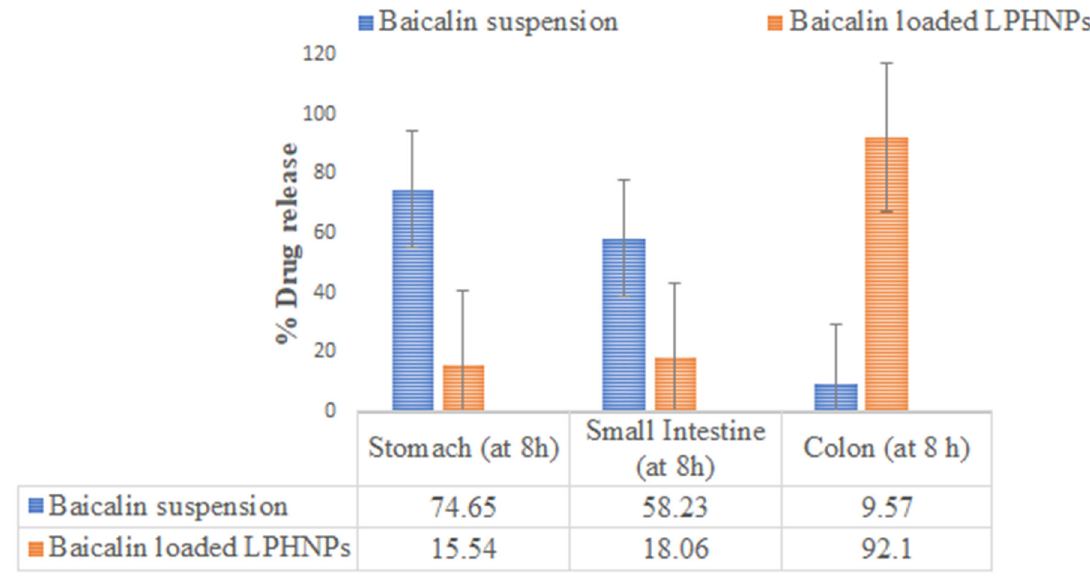
Figure 7. Baicalin content in GIT-isolated organs of rat after oral administration of baicalin suspension and baicalin-loaded LPHNPs. Each value represents mean ± S.D of three determinations. p < 0.05, compared with baicalin suspension.